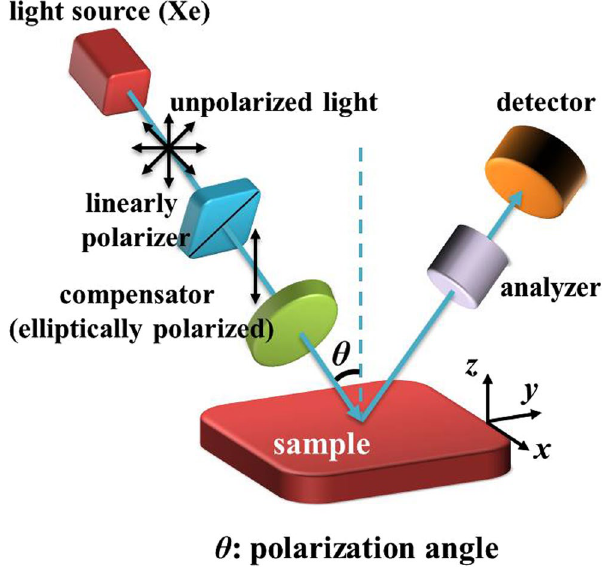
Figure 5. Schematic drawing of the reflected polarization measurement setup.